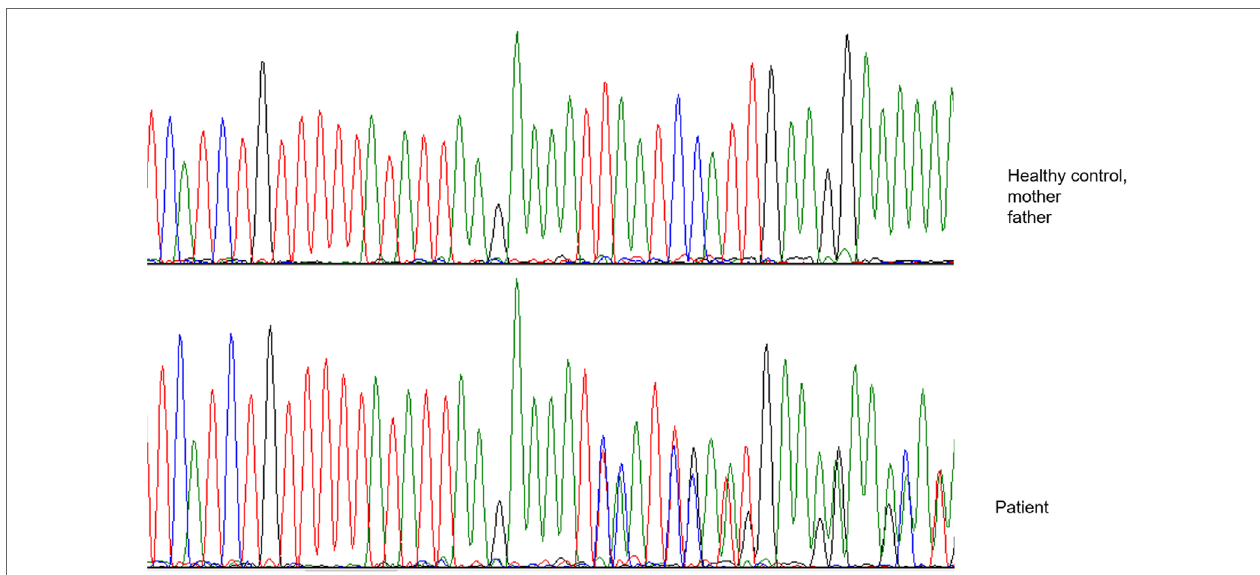
FIGURe 3 | electropherogram showing a heterozygous four-nucleotide deletion in the patient, as contrasted with a healthy control and the patient’s parents